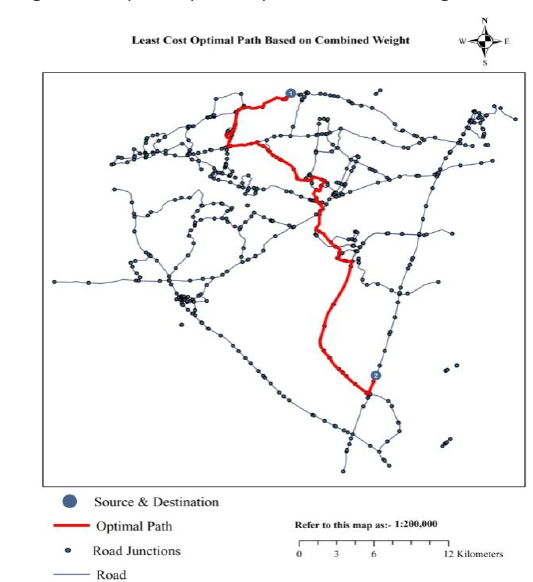
Figure 10. Optimal path map based on population density Figure 11. Optimal path map based on travelling distance